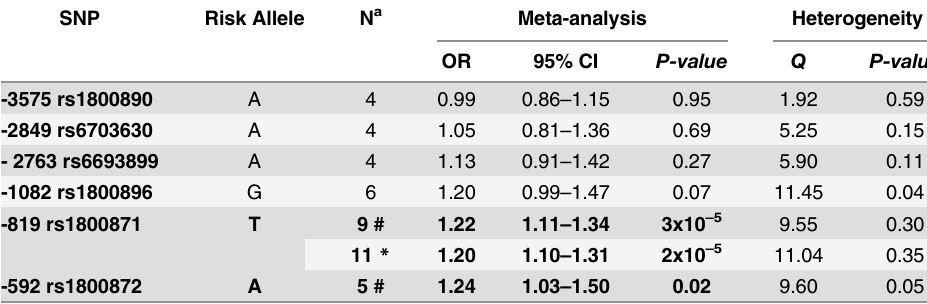
Table 4. Meta-analysis results from studies investigating leprosy association and IL10 promoter polymorphisms. SNP Risk Allele N a Meta-analysis